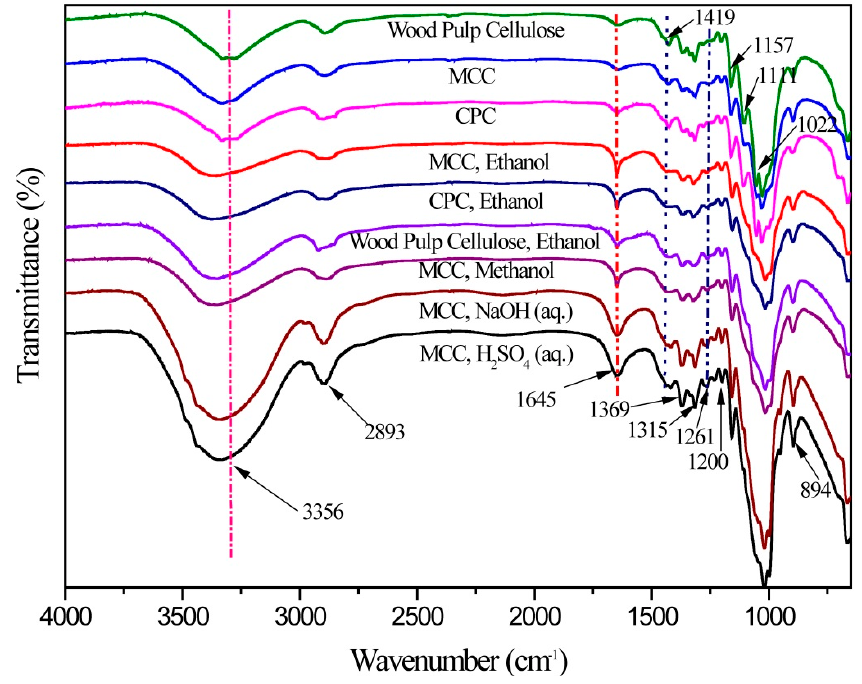
Figure 3. FT-IR of raw cellulose and regenerated cellulose films.